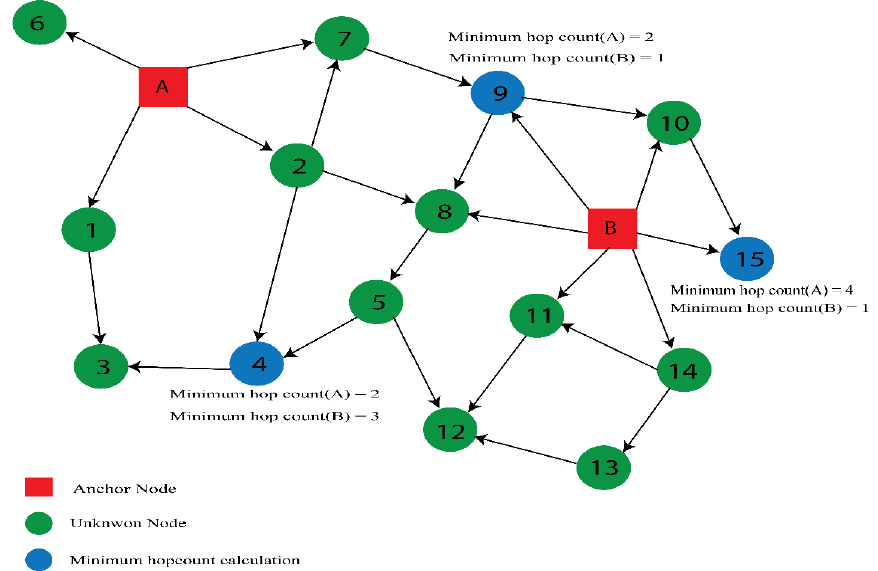
Sensors 2023 , 23 , x FOR PEER REVIEW Figure 2. Determining minimum hop count. Figure 2. Determining minimum hop count.